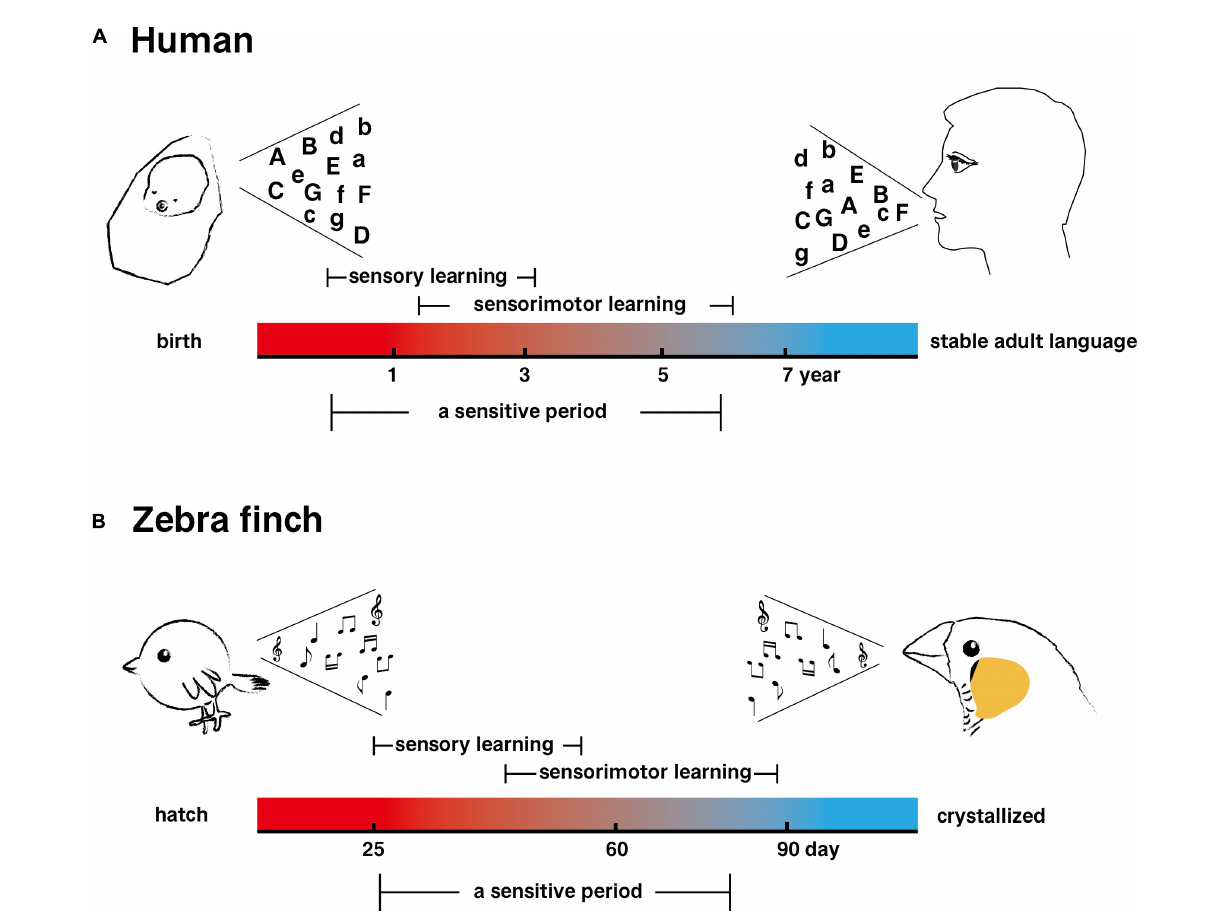
FIGURE1 A comparison between the learning process of human speech and that of songbird singing. (A) The process of human speech learning. (B) The song learning process of a male zebra